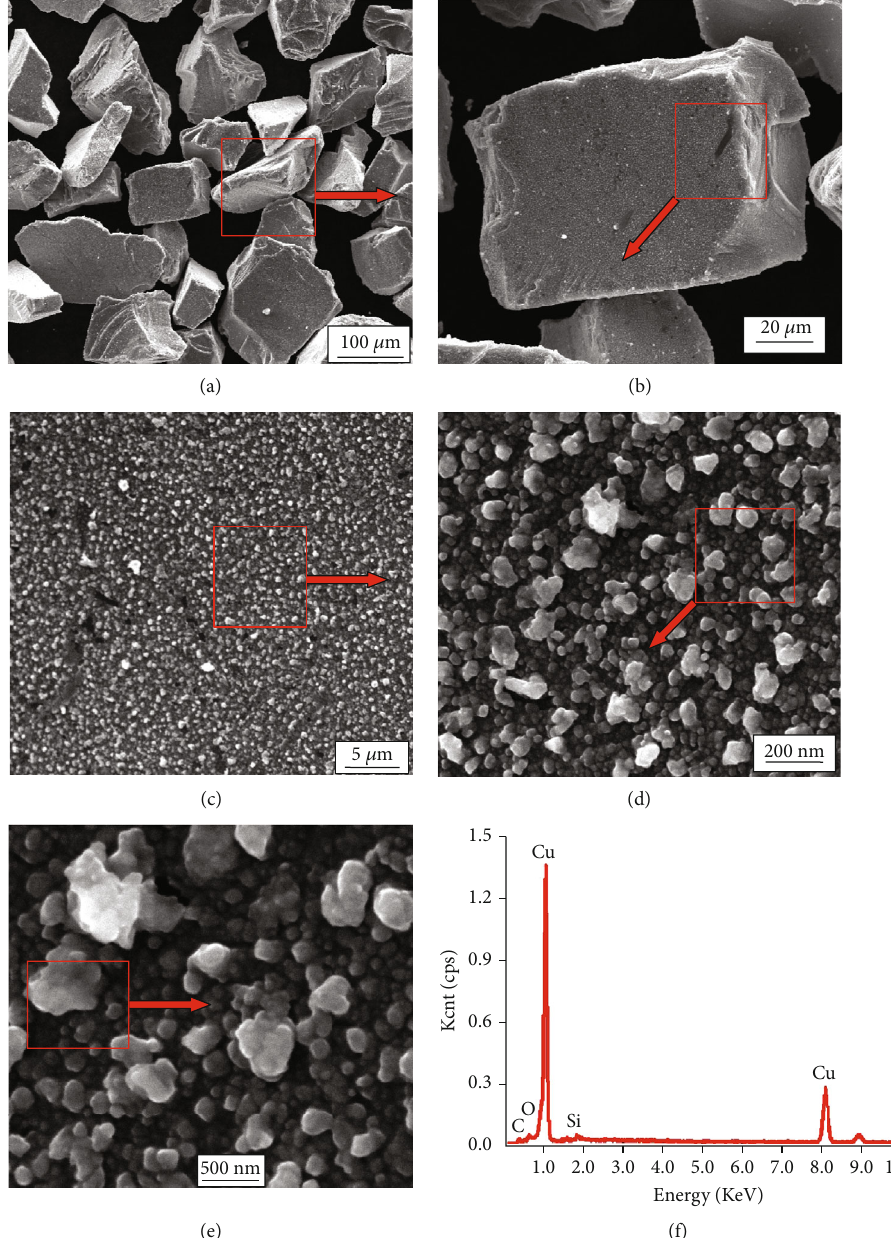
Figure 3: Morphology of the copper fi lm on β -SiCp after magnetron sputtering was formed. β -SiCp with the copper fi lm at low magni fi cation (a) and high magni fi cation (b – e) and energy pattern